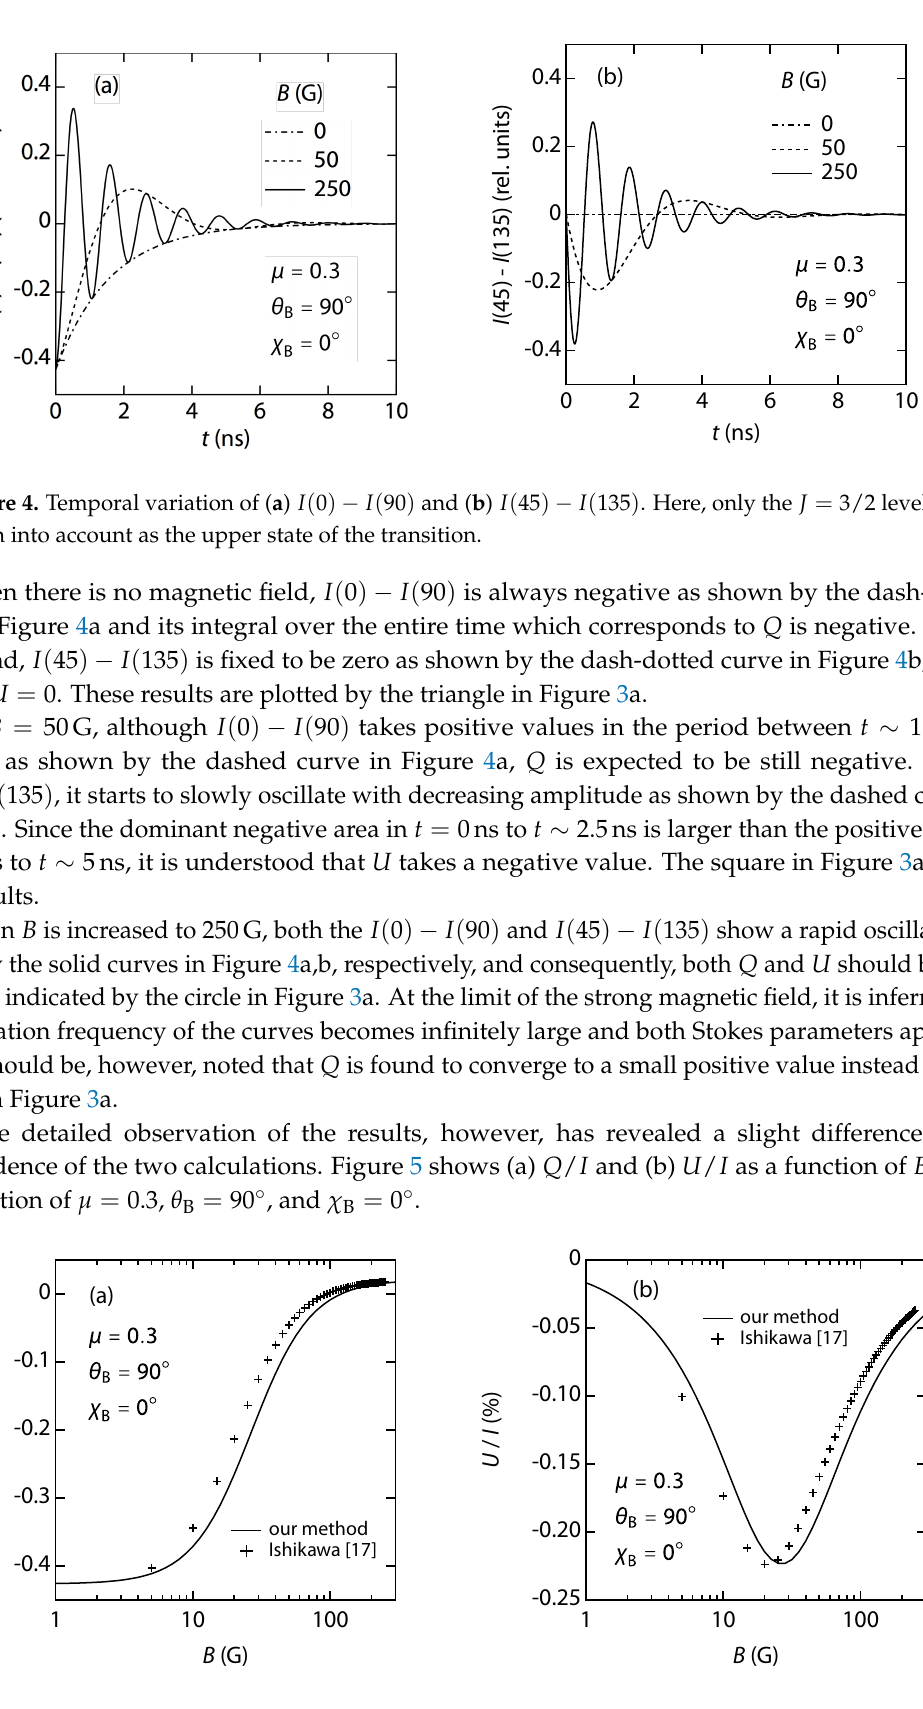
Figure 5. B -dependence of Q / I ( a ) and U / I ( b ) under the condition of µ = 0.3, θ B = 90 ◦ and χ B = 0 ◦